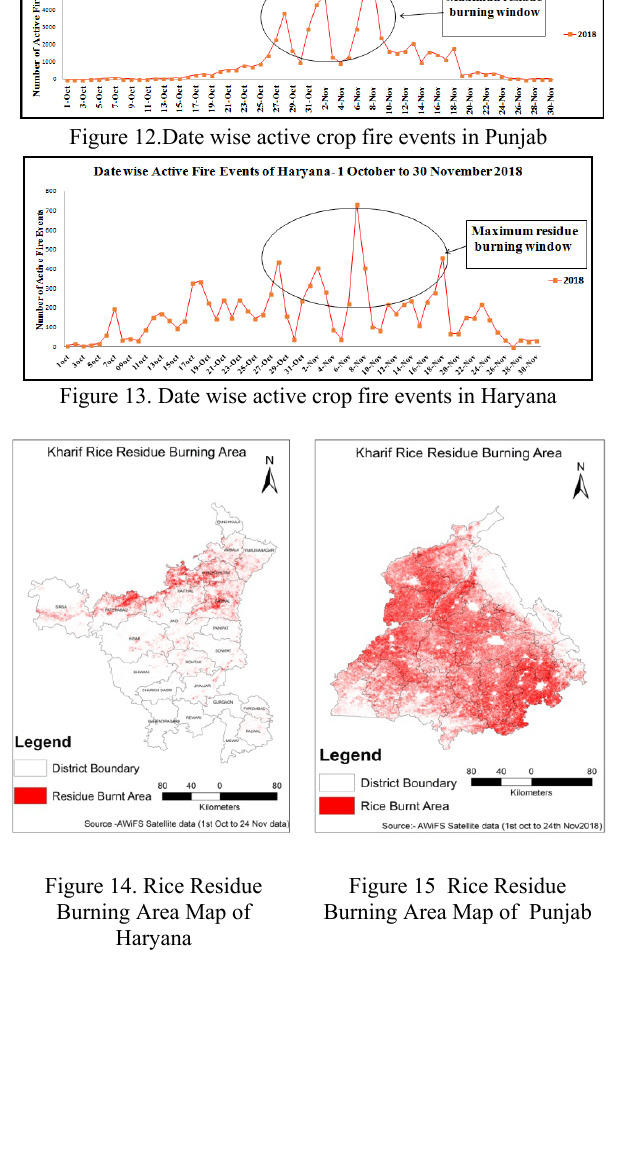
Figure 12.Date wise active crop fire events in Punjab